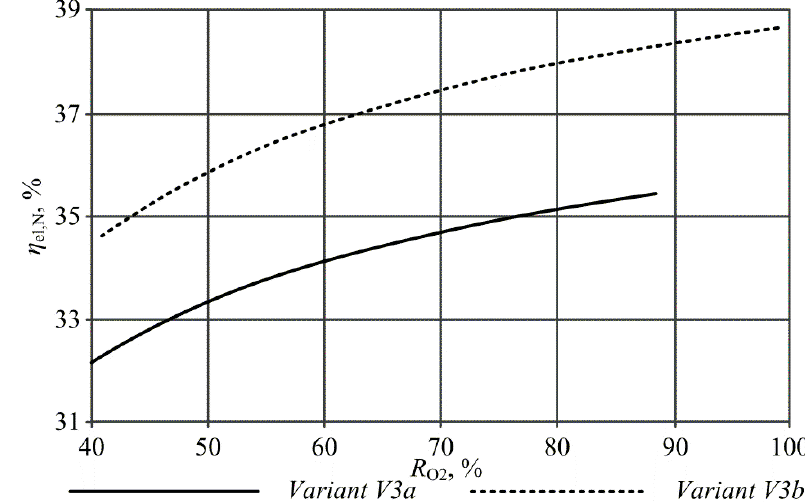
Figure 16. Net e ffi ciency of electricity generation as a function of the oxygen recovery Figure 16. Net efficiency of electricity generation as a function of the oxygen recovery rate.